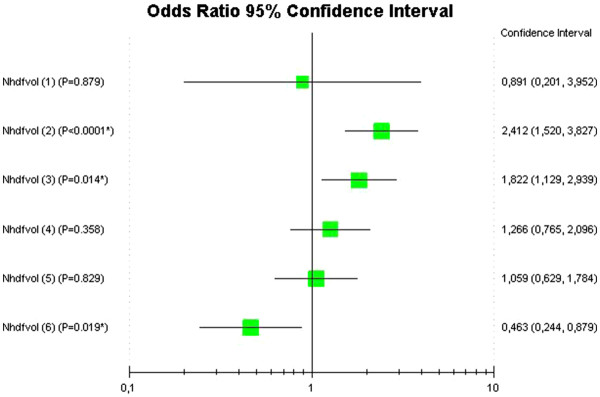
Forest plot diagram to represent odds ratio of hemodiafiltration volume for Intradialytic Hypotension. The groups of convective volume were defined as follows: Group 1: 0 to 0.2 liters. Group 2: 0.3 to 7.53 liters, Group 3: 7.54 to 14.8 liters; Group 4: 14.9 to 16.96 liters; Group 5: 16.97 to 18.9 liters; Group 6: 19.1 to 21 liters, and Group 7: 21.1 to 30 liters.